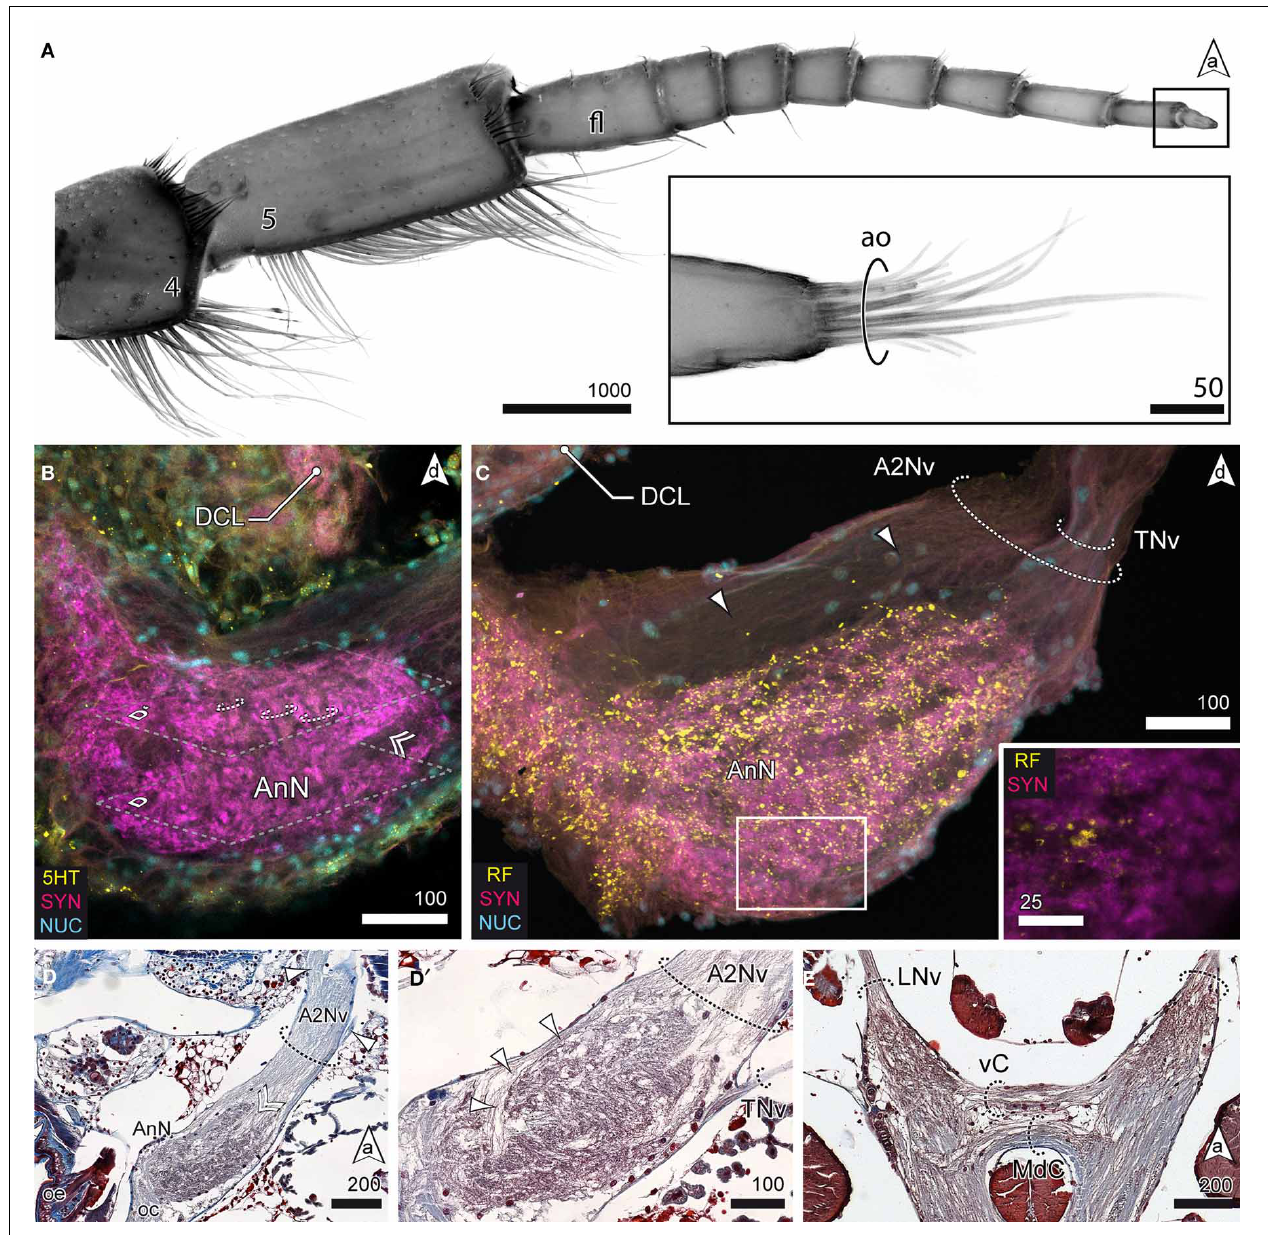
A2Nv bypass the neuropil anterodorsally and the target domains in the posterior parts of the neuropil. SYNir illustrates the microglomerular organization of the AnN (inset C ). (D) Nerves emerging from A2Nv target muscles at the base of antenna 2 (arrowheads). Parts of A2Nv enter the neuropil in a groove like depression (double arrowhead). (E) Anterior part of the VNC showing two commissures connecting the oc. An anterior vC giving rise to LNv and the posterior